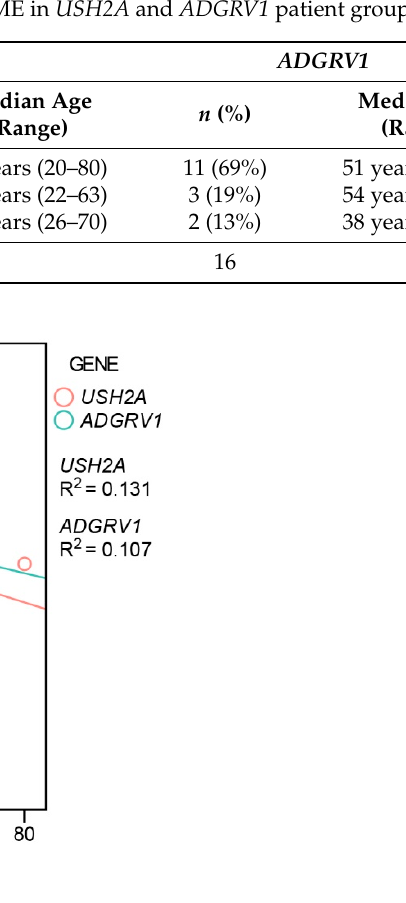
Figure 5. Central foveal thickness in relation to age and genotype. Red color represents USH2A patients and green color represents ADGRV1 patients.